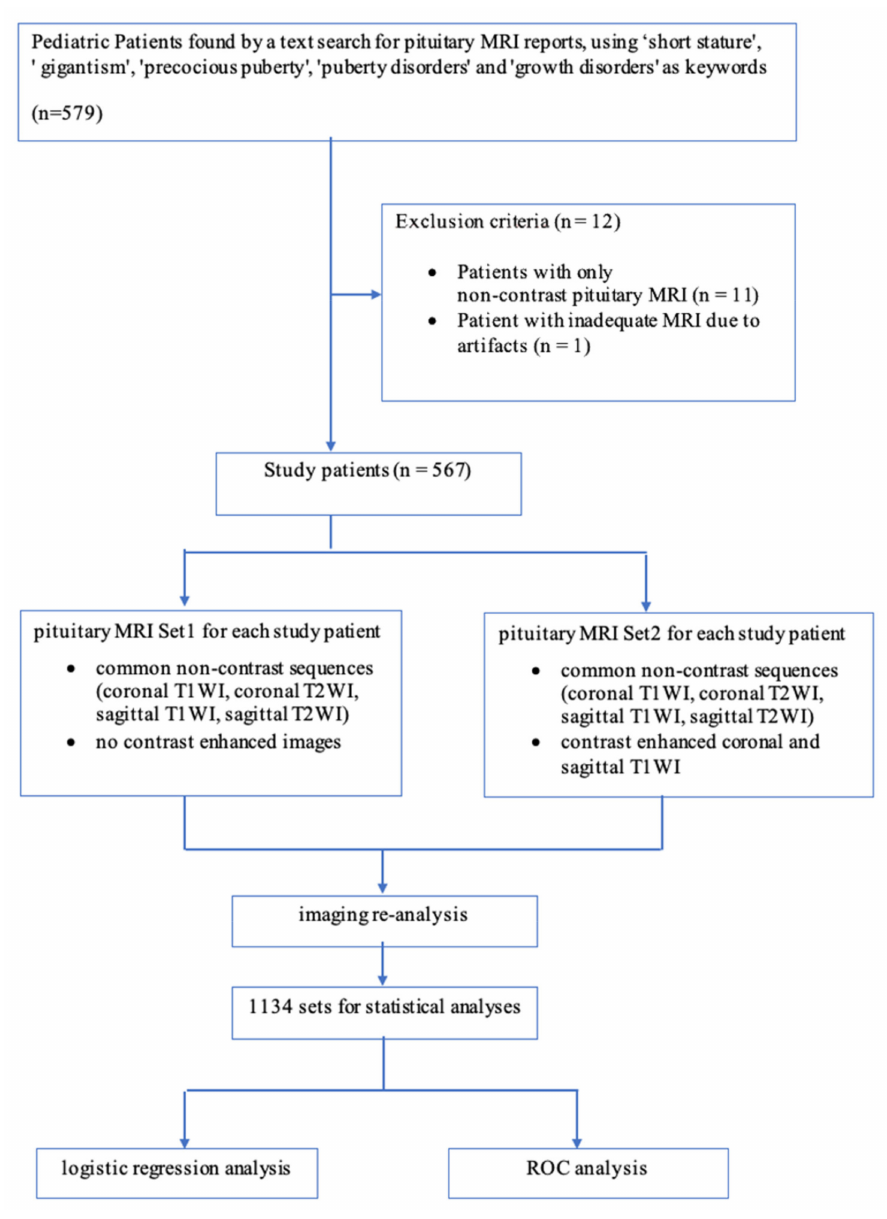
Figure 1. Flowchart of the patient inclusion process and image analysis. T1-WI = T1-weighted imaging, T2-WI = T2-weighted imaging, ROC analysis = Receiver operating characteristic